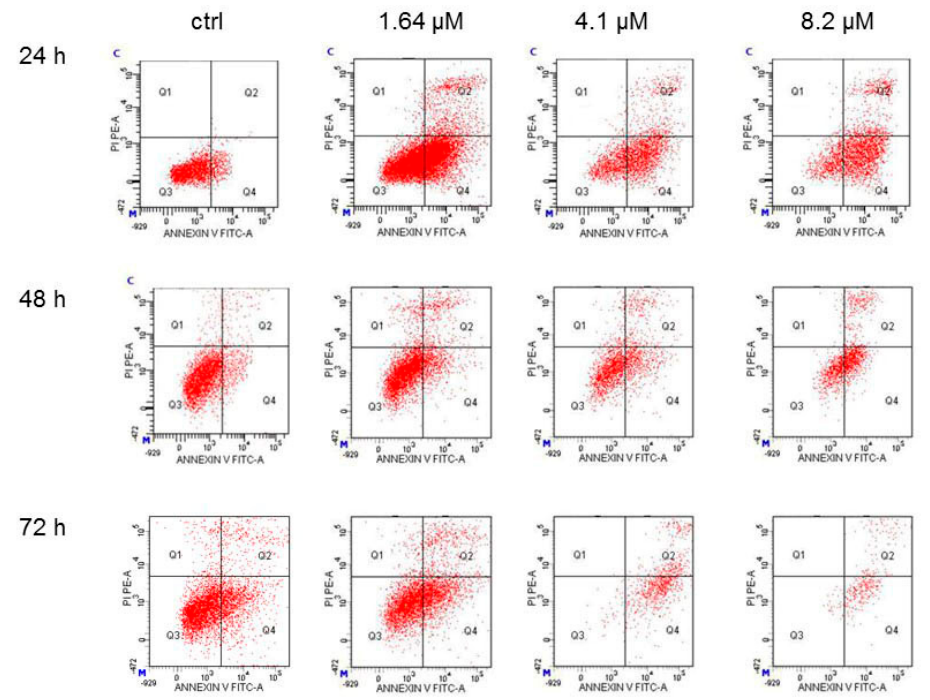
Figure 4. Cytofluorimetric evaluation of apoptosis on the SH-SY5Y cells exposed to moringin. Detection of apoptosis was performed by the Annexin V test. Representative Annexin V vs. PI dot plots of the SH-SY5Y cells treated with 1.64–8.2 µ M of moringin for 24–72 h are shown. Q3 contains the viable cells, Q4 the cells in early apoptosis, Q2 the cells in late apoptosis, and Q1 contains the necrotic cells. The FACS analysis presented is representative of three different experiments.